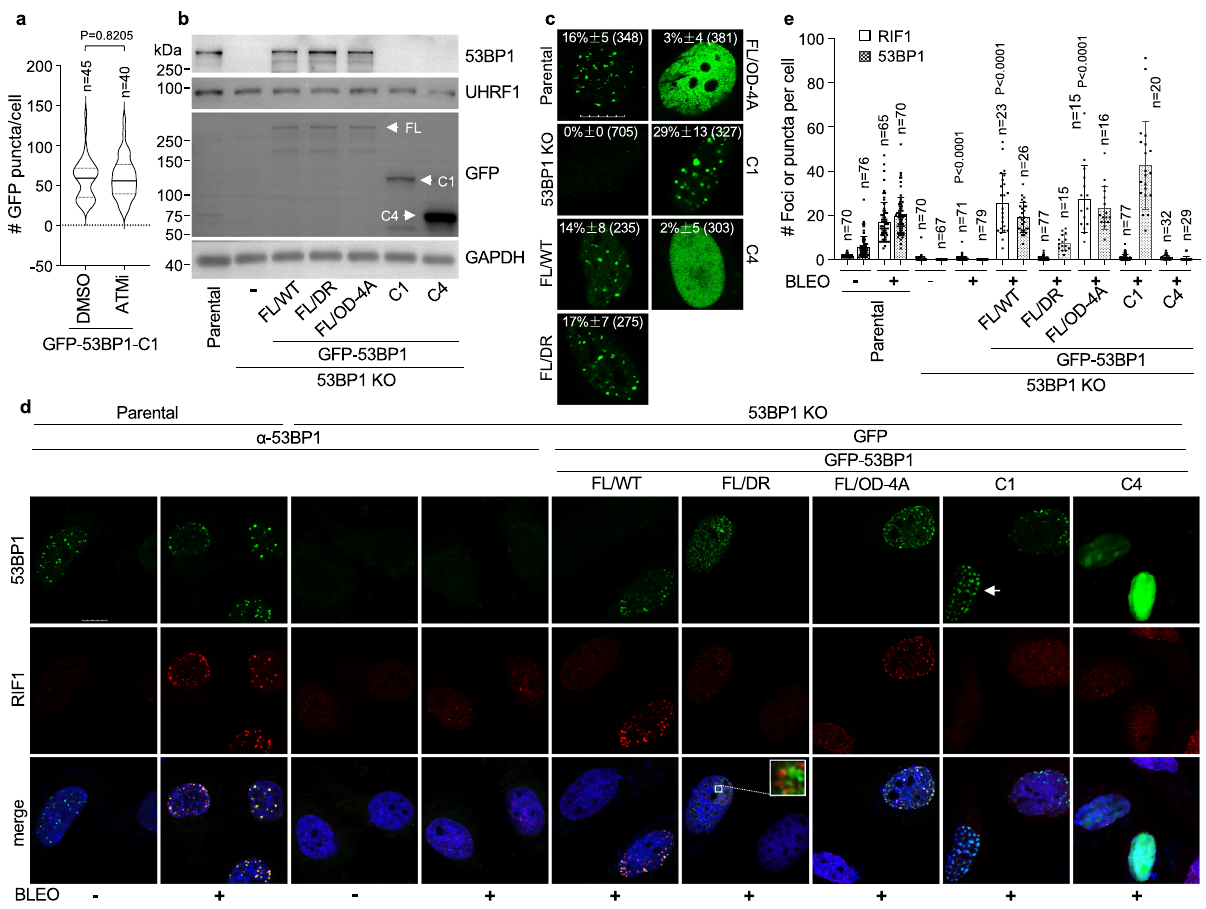
Fig. 7 Uncoupling between LLPS and DSB repair of 53BP1. a U-2 OS cells were transfected with GFP-53BP1-C1 for 36 h, treated with 500 nM ATM inhibitor (ATMi) for 12 h, and the number of GFP-53BP1-C1 puncta per cell was counted and presented as Violin plot from indicated number of cells from two independent experiments. Data represent mean, 25th, and 75th percentiles with the whiskers extending to the minimum and maximum values. b 53BP1 KO U-2 OS cells re-constituted with GFP-53BP1 constructs and protein expression was examined. The uncropped blots are provided in the Source Data fi le. c Representative single z-plane confocal images of 53BP1 puncta in the absence of DNA damage. Quantitation of the percentage of GFP puncta positive cells from n = 18, 28, 33, 31, 30, 37, and 34 images for each group were analyzed from indicated number (in parenthesis) of cells and presented as mean values and SD acquired from at least two independent experiments. d U-2 OS cells from ( b ) were treated with 3.5 μ M bleomycin for 6 h, fi xed and stained with the anti-RIF1 antibody. Representative single z-plane confocal images are shown. Green signals in non-transfected cells represent endogenous 53BP1 by anti-53BP1 antibody staining. Square: an enlarged area showing rare co-localization between 53BP1-FL/DR and RIF1 foci, which helps determine this cell being 53BP1-FL/DR puncta positive, but DSB foci negative. Arrow: a cell showing 53BP1-C1 forming liquid droplets, but not DSB foci determined by the puncta size. Scale bar in all images is 10 μ m. e Foci or puncta number of RIF1 and 53BP1 from indicated number ( n ) of cells in ( d ). Data represent mean values and SD from two independent experiments. Unpaired two-tailed t test was performed in Prism 9.0 with 95% con fi dence intervals in ( a ) and ( e ). In ( e ), while the 53BP1 KO group was compared to the parental group in the presence of BLEO, others were compared to the 53BP1 KO group in the presence of BLEO for statistical